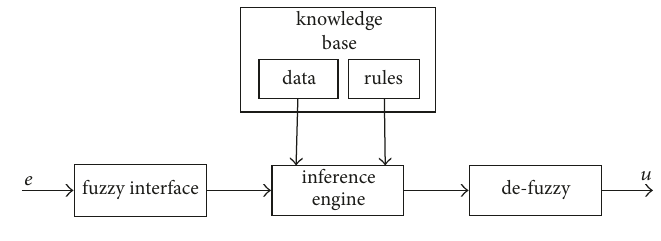
Figure 1: Fuzzy inference unit.